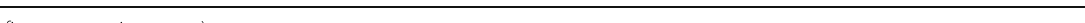
(See figure on previous page.) Fig. 6 In vitro osteogenic and anti-ROS activity of the active compound 3-O-methylpatuletin (K008) in primary osteoblast cells. a - b Representative images of compound K008 treated Alizarin Red-S stained cells and quantification. Relative change in expression of osteogenic genes ( c ) RUNX2, ( d ) BMP2, ( e ) ALP, ( f ) COL1 in calvarial osteoblasts treated with compound K008 as compared to control by qPCR. * p < 0.05, ** p < 0.01, *** p <